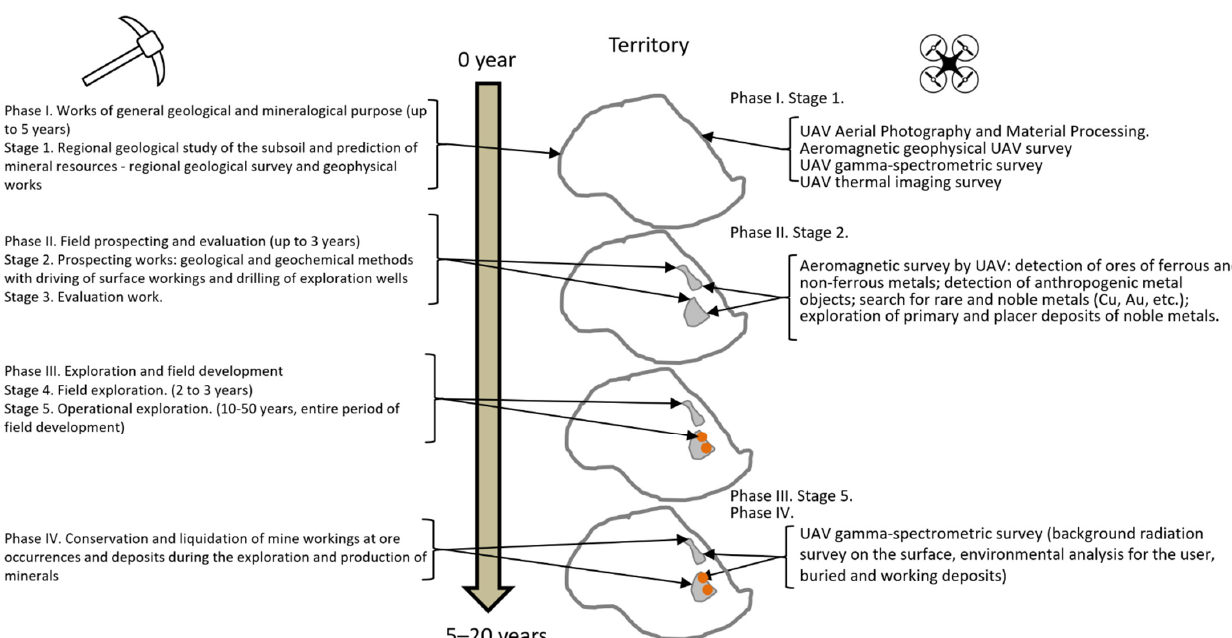
Figure 5. The use of UAV at various stages of geological exploration and mining. Source: Generated by the authors.